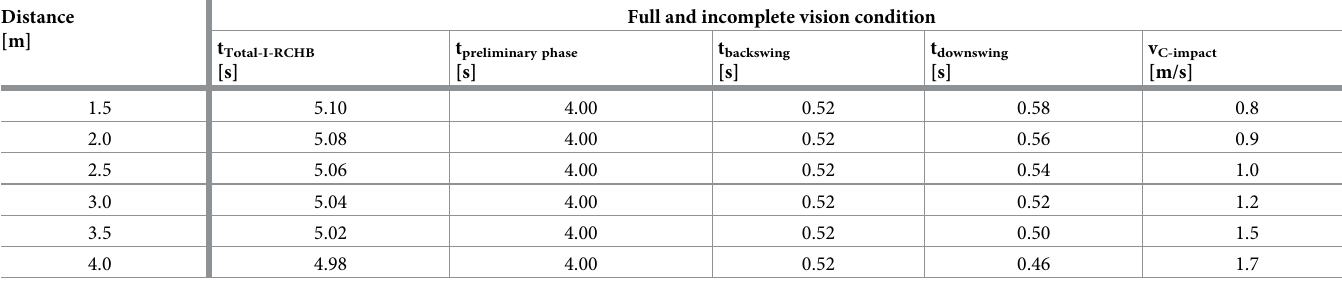
Table 3. Temporal and kinematic differences between the 6 putting distances under full and incomplete vision conditions. Distance [m]